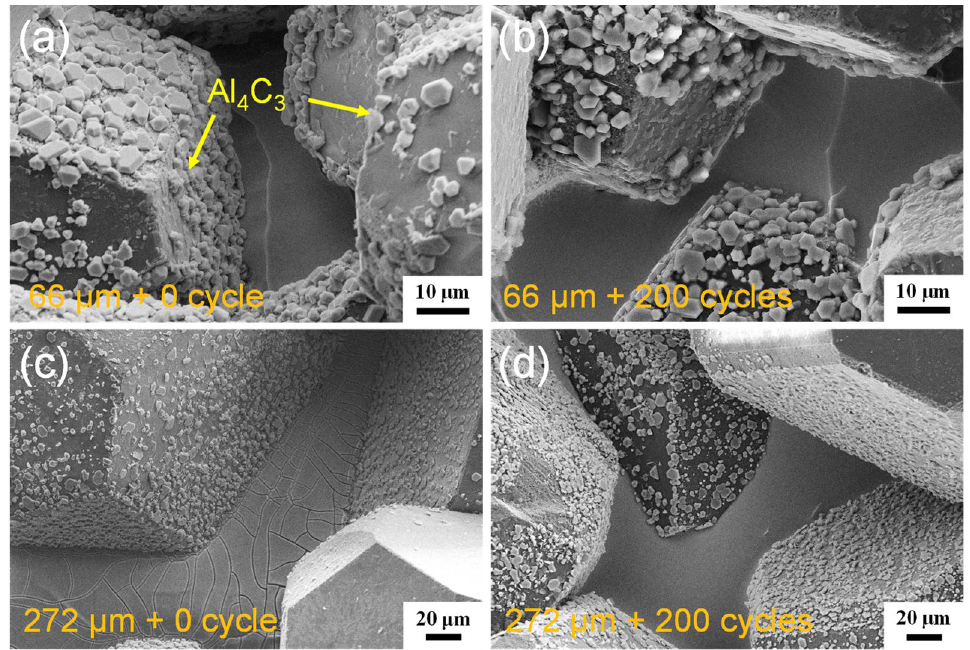
Figure 5. Interface morphologies of the diamond/Al composites with different diamond particle sizes before thermal cycling: ( a ) 66 μm and ( c ) 272 μm, and after 200 thermal cycles; ( b ) 66 μm and sizes before thermal cycling: ( a ) 66 µ m and ( c ) 272 µ m, and after 200 thermal cycles; ( b ) 66 µ m and ( d ) 272 μm. ( d ) 272 µ